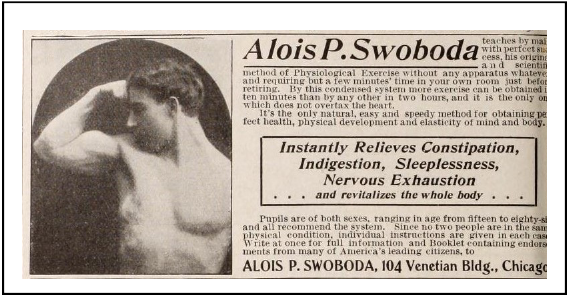
Figure 6. The Swoboda Method. Christian Herald , 6 January 1900, p. 918.